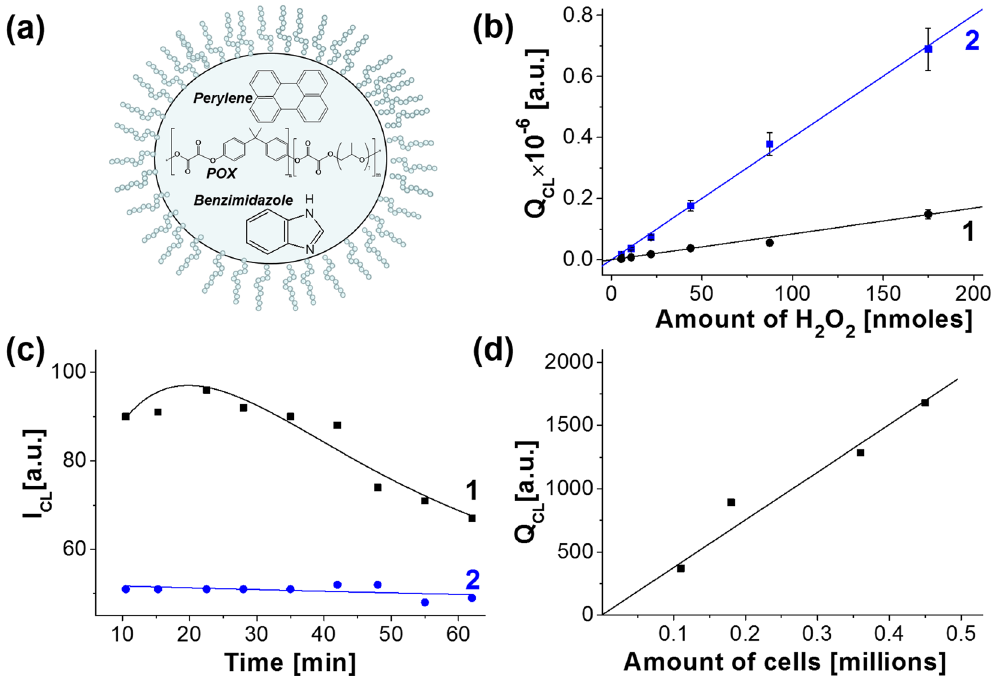
Figure 6. PO-CL reaction in cells under oxidative stress conditions. ( a ) Scheme of the modified CLD formulation designed for the enhancement of chemiluminescence efficiency. ( b ) Dependences of chemiluminescence on the amount of H 2 O 2 for TMHP- (1) and perylene- (2) based CLD. Concentrations of the activators were 0.48 mM in both cases. TMHP-based dispersion contained 26 mM imidazole, while perylene- based dispersion contained 1 mM benzimidazole. ( c ) Kinetics of light emission by 0.45 millions of MCF-7/ ADR cells after addition of 0.2 mL of complete CLD containing 2.1 mM POX repeat units, 0.48 mM perylene and 1 mM benzimidazole (1) and a control formulation without perylene (2). The dispersions were prepared in DMEM supplemented with 10 mM HEPES, pH 7.4 without serum, bicarbonate and Phenol Red, 37 °С. The data were obtained using plate luminometer. ( d ) The dependence of the integral light emitted during PO-CL reaction in the cells on their amount in the